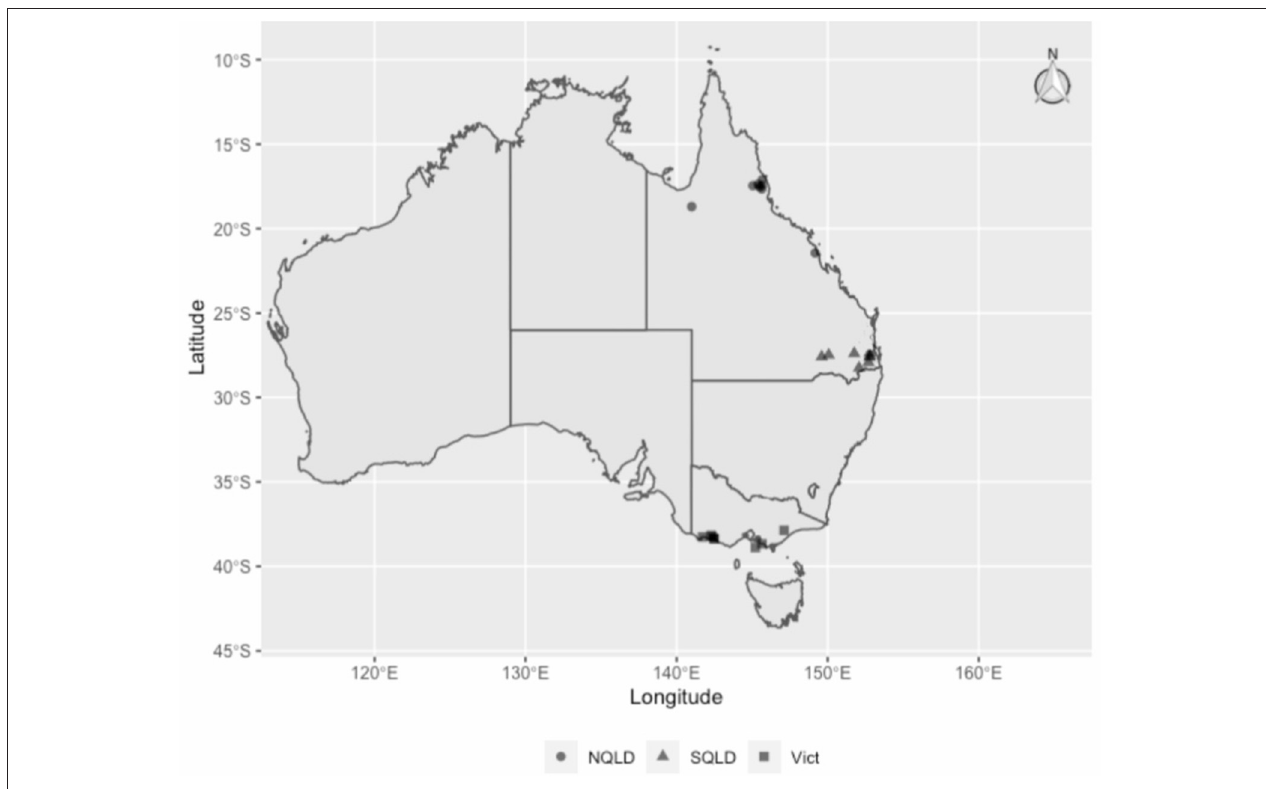
FIGURE 1 | The study herds’ regions and locations: circles for Northern Queensland (NQLD), triangles for Southeast Queensland (SQLD) and squares for Victoria (Vict).